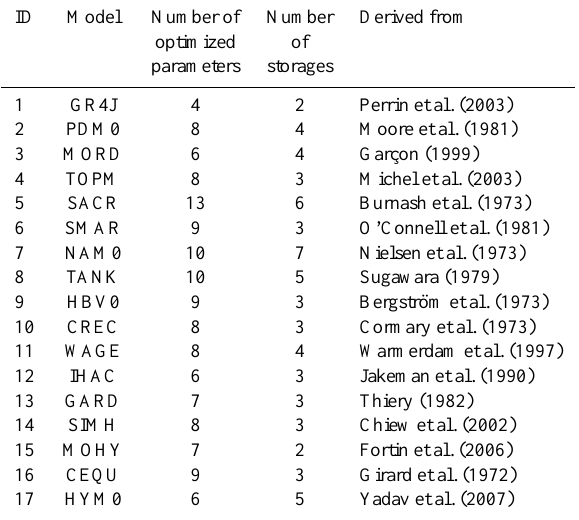
Table 2. Models identification and